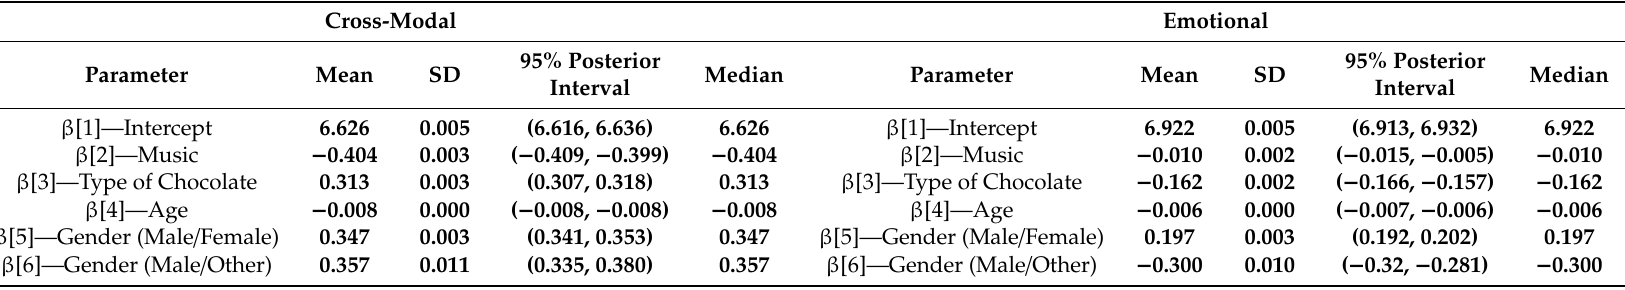
Table 5. Posterior means, posterior standard deviations, 95% credible intervals, and posterior medians for all parameters in the Poisson cross-modally corresponding (left) and emotional (right) music regression models for willingness to pay (WTP) ratings. Values highlighted in bold represent stronger evidence of associations. Values in italics constitute weaker evidence of